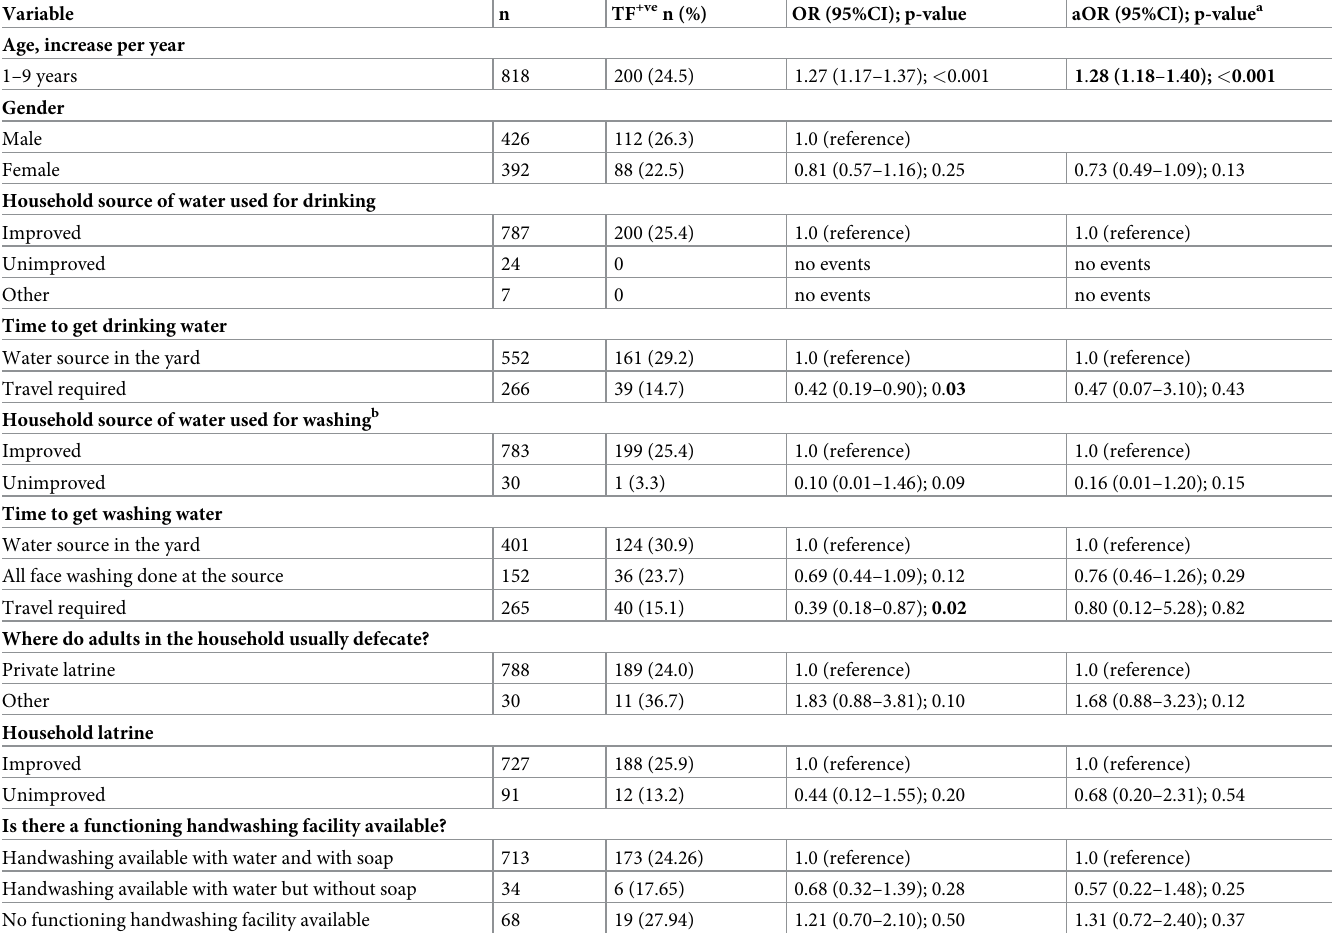
Table 1. Factors associated with trachomatous inflammation—follicular (TF) in children aged 1–9 years, Nauru, July 2019 (n =